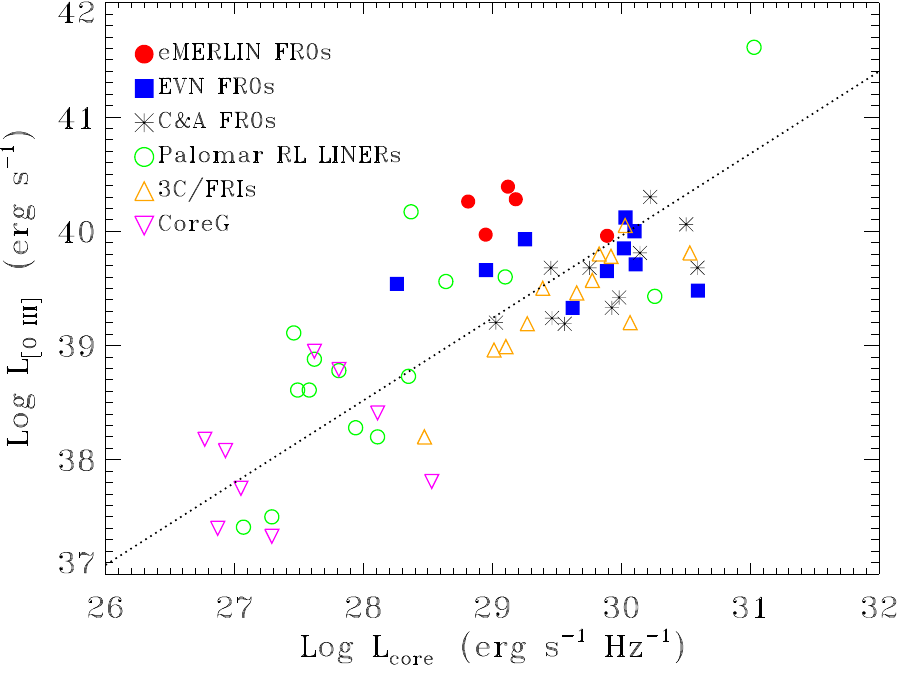
Figure 5. Parsec-scale core radio power (erg s − 1 Hz − 1 ) vs. [O III] line luminosity (erg s − 1 ) for different samples of LINER-type RL AGNs hosted in ETGs with core-brightened morphologies (see the legend): red dots for the e MERLIN FR 0 subsample, blue filled squares for the EVN FR 0 subsample, black stars for FR 0s from [87,88], green empty circle for RL Palomar LINERs, upwards orange triangles for 3C/FR Is, downward pink triangles for core galaxies (see Section 4 for details). The dotted line indicates the best linear correlation found for all the